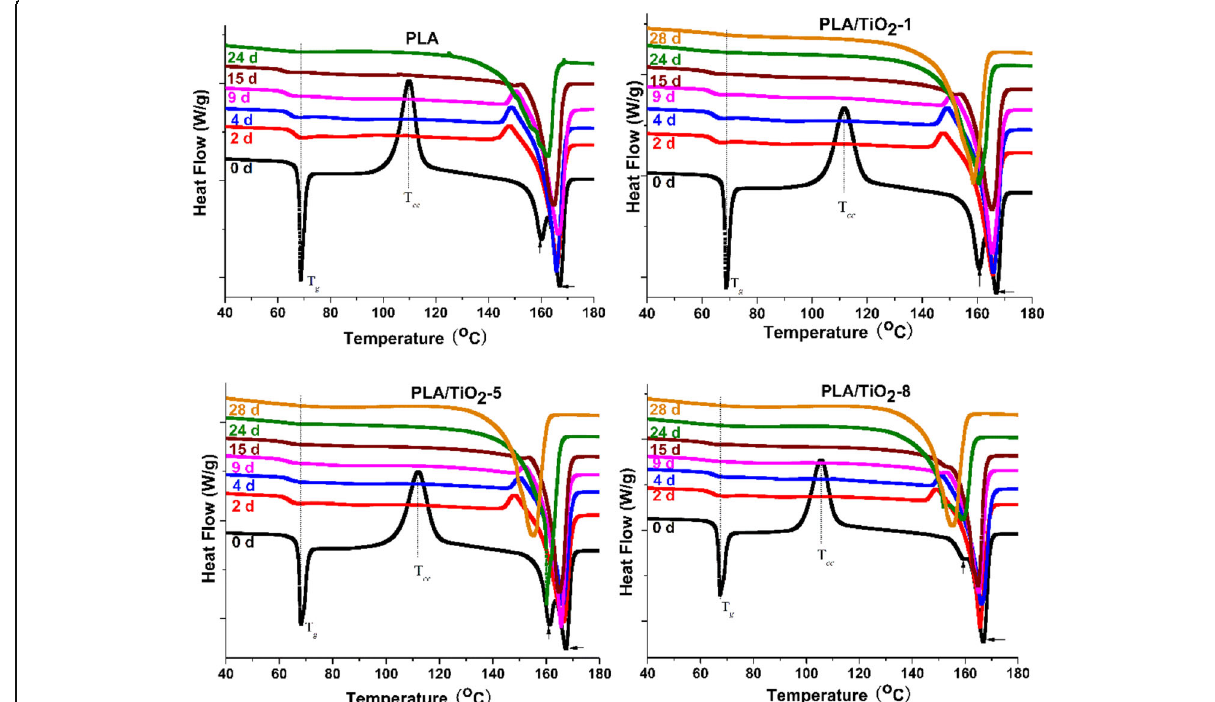
Fig. 2 DSC thermograms of biodegradation products of pure PLA and PLA/TiO 2 nanocomposites at different incubation times, first heating scan